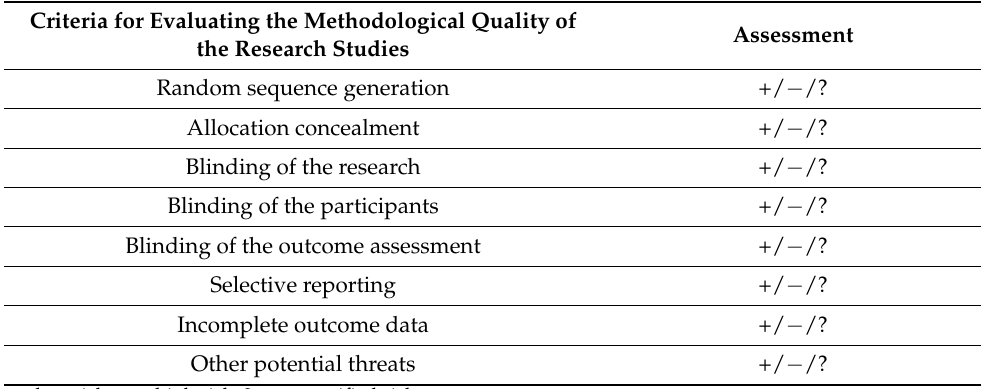
Table 1. Criteria for evaluating the methodological quality of the research studies [18].